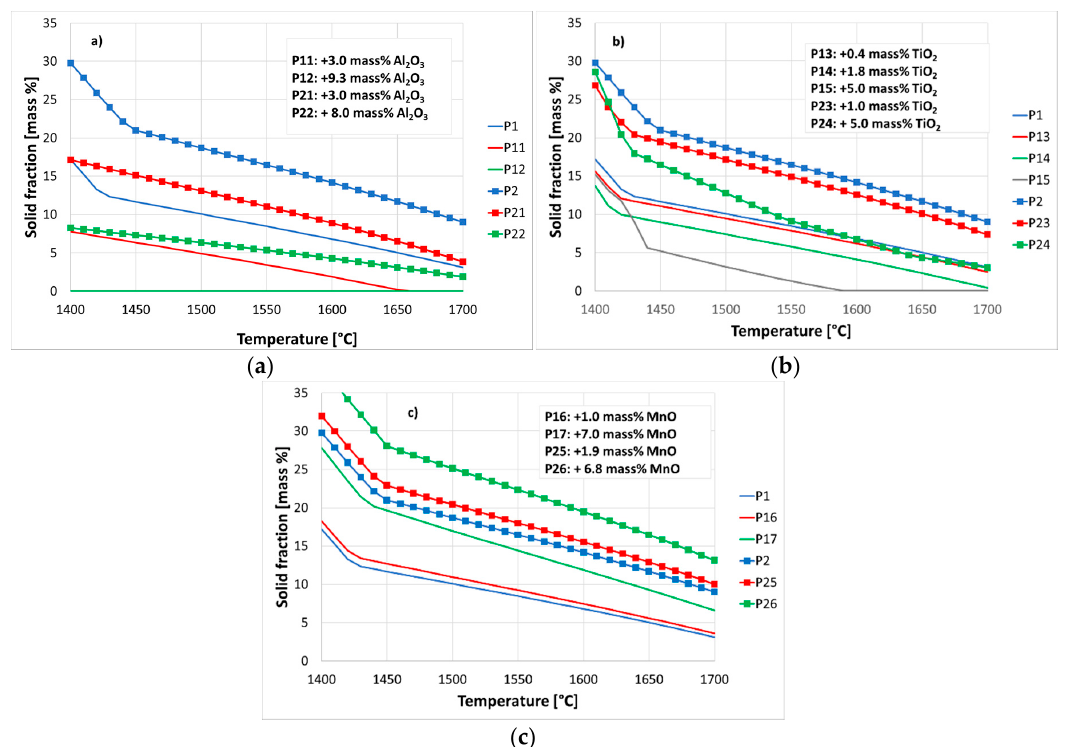
Figure 1. Solid fraction with respect to temperature for the addition of ( a ) Al 2 O 3 ( b ) TiO 2 , and ( c ) MnO.